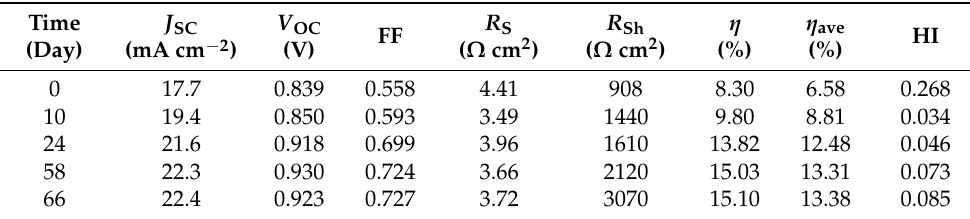
Figure 7. ( a ) Changes of the J-V curves for the champion device in the present work. ( b ) X-ray diffraction patterns of 100 reflections. Table 3. Photovoltaic parameters of champion device, treated with DPPS in chlorobenzene and annealed at 190 ◦ C for 5 min.